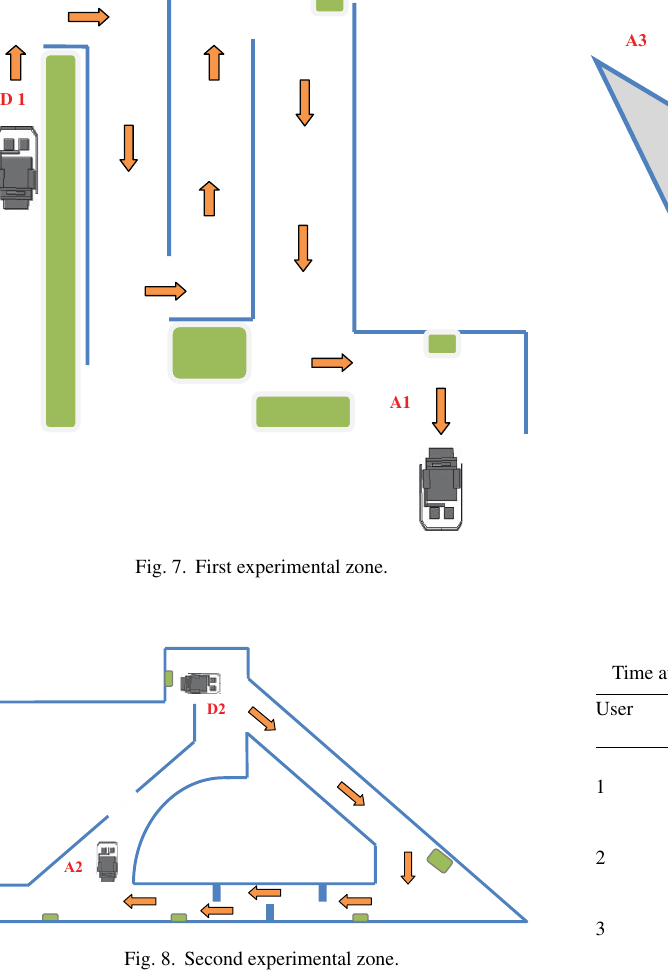
Fig. 8. Second experimental zone.